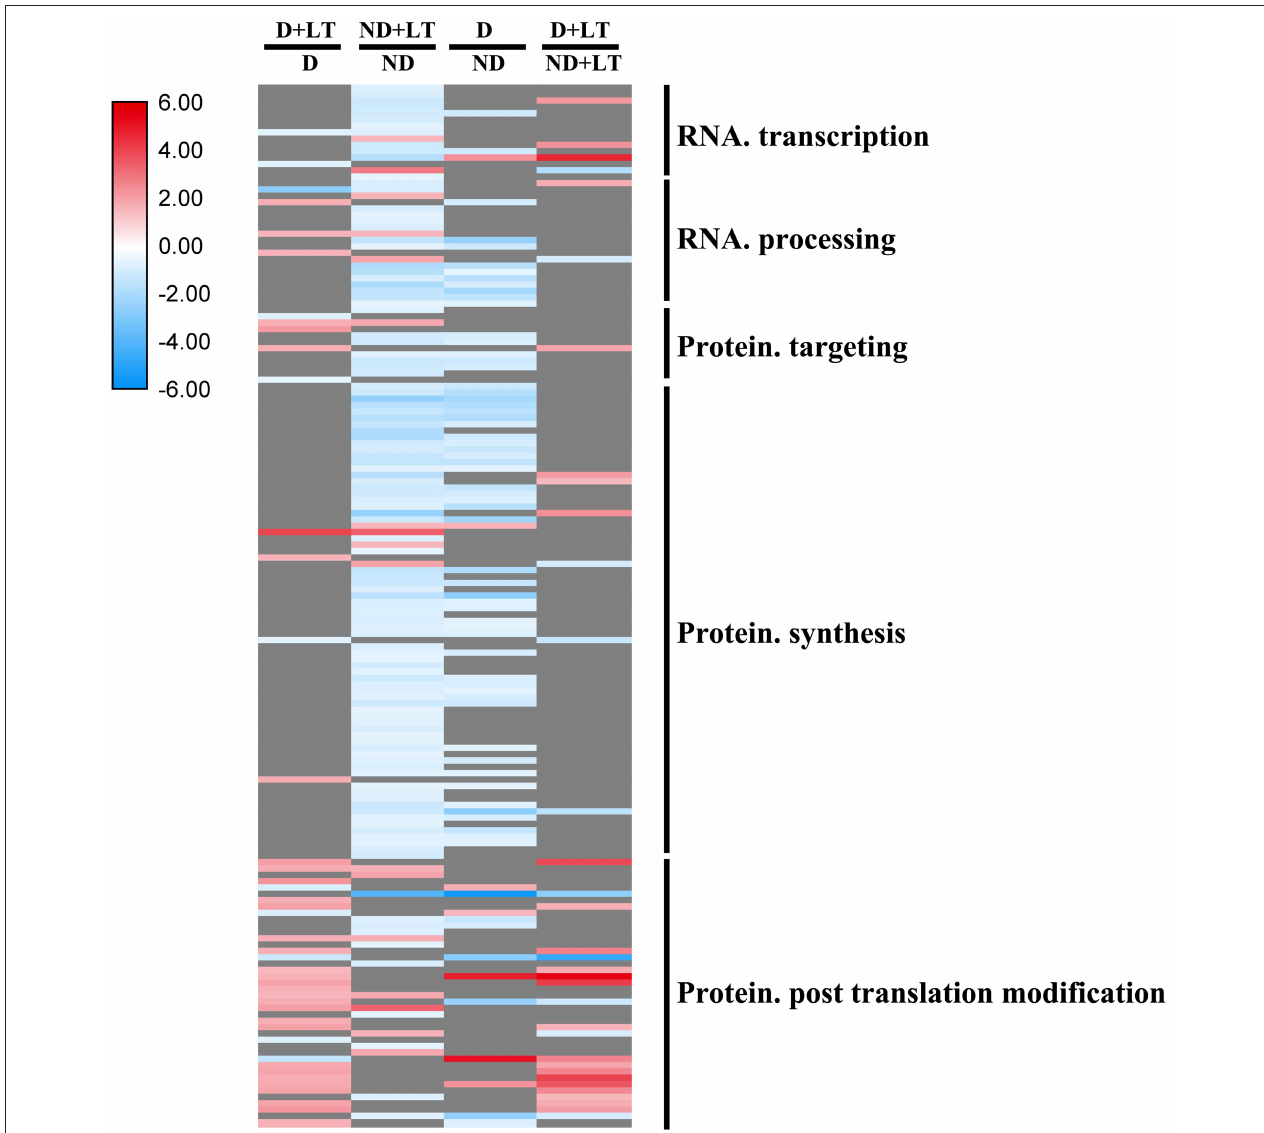
FIGURE 5 | Transcript profiles of RNA and protein synthesis genes in different dominancy varieties of alfalfa under LT. The color scale indicates log 2 -transformed fold changes in expression levels between dormancy (D) and non-dormancy (ND) genotype under normal growth conditions or LT conditions. Red, blue, and gray denote upregulation, downregulation, and no change in expression,